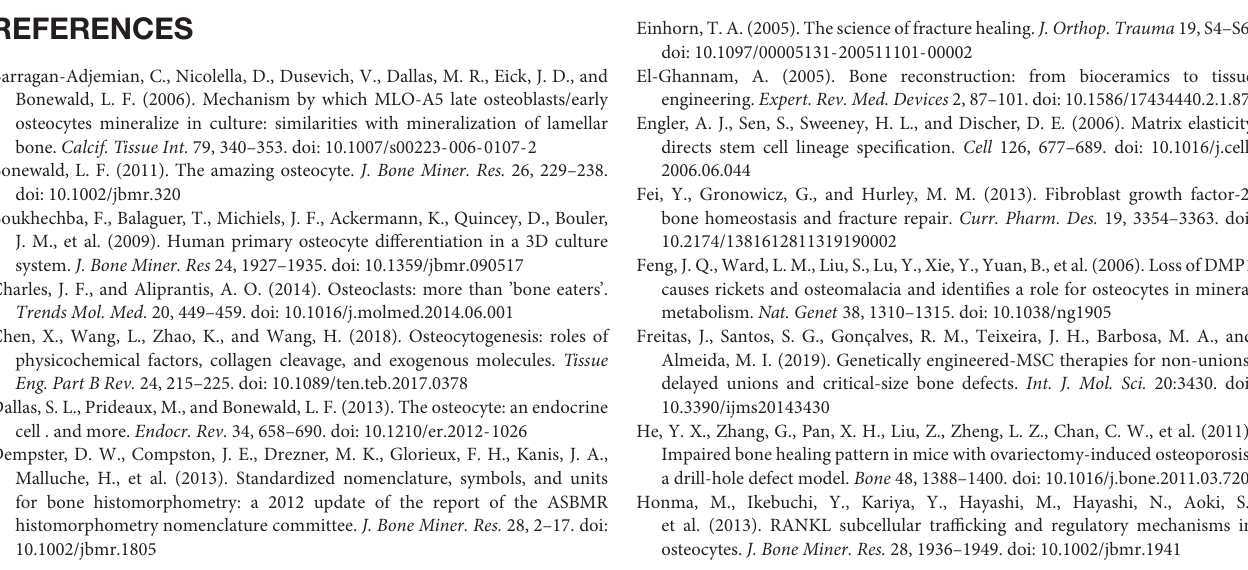
FIGURE S1 | (A) Schematic representation of the drill-hole defect model using micro-CT analysis. (B) After drill-hole surgery for 1 week, mice were sacrificed and the tibiae were subjected to pQCT examination. Total BMD (including trabecular and cortical bone) from tibiae of SHAM ( n = 4) and OVX (hydrogel group, n = 5) mice. Data were represented as means ± s.e.m. TABLE S1 | Primers used in RT-PCR